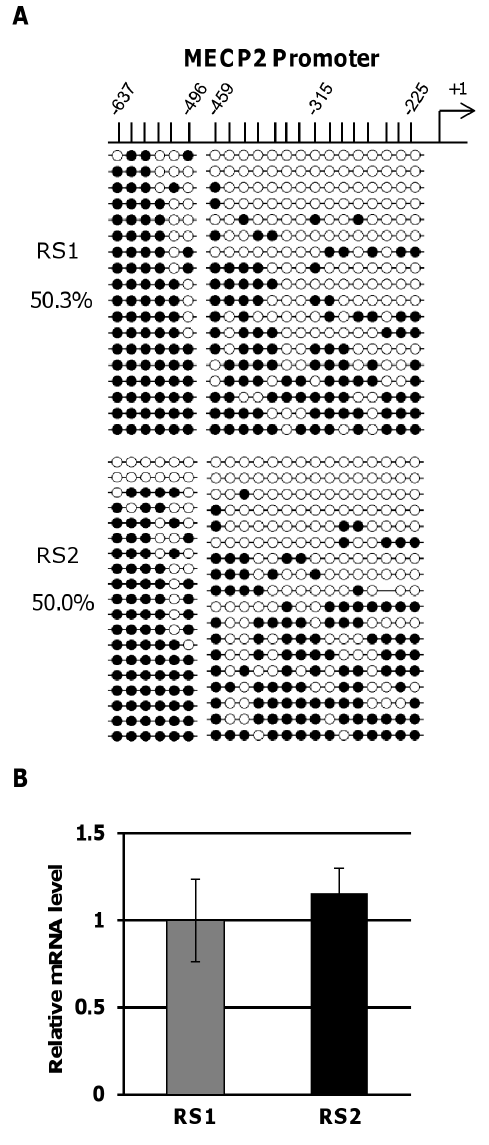
Figure 3. DNA methylation and expression analyses for the MECP2 gene. (A) DNA methylation profile in the upstream region of MECP2 by bisulfite sequencing. The upper number indicates the position of the CpG from the transcription start site of MECP2 . (B) Results of a qRT-PCR assay for MECP2 gene.